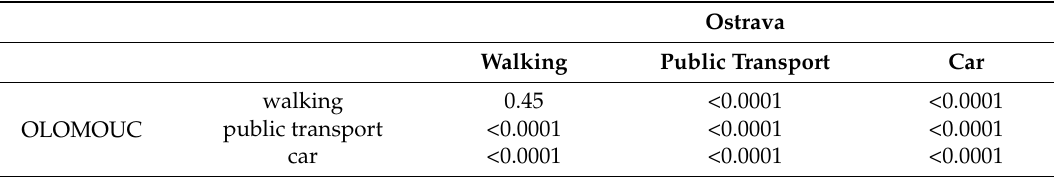
Figure 4. Route distance differences between cities, transportation modes in different city districts. Table 1. p -values of Wilcoxon tests for differences between transportation modes in cities.